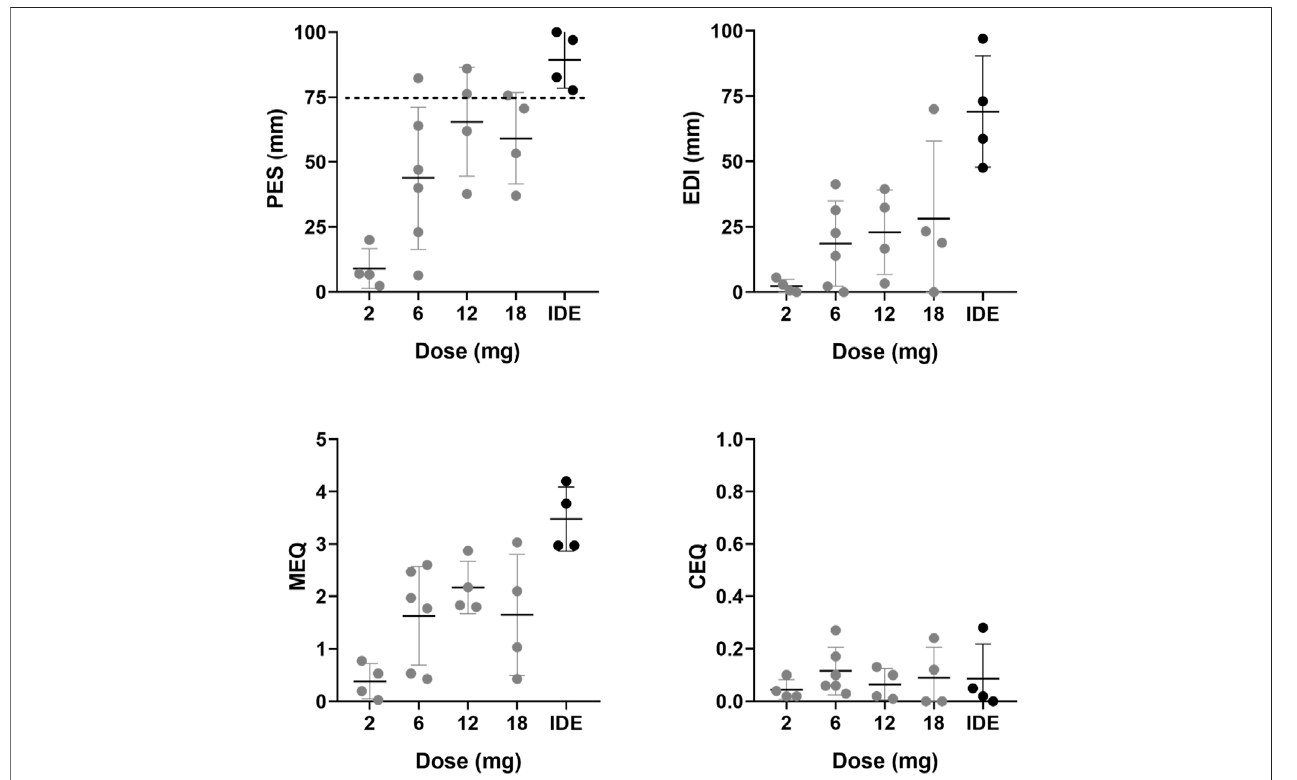
FIGURE 1 | Mean (SE) and individual retrospective ratings of the acute psychedelic experience (PES, EDI, MEQ, CEQ) per dose level.